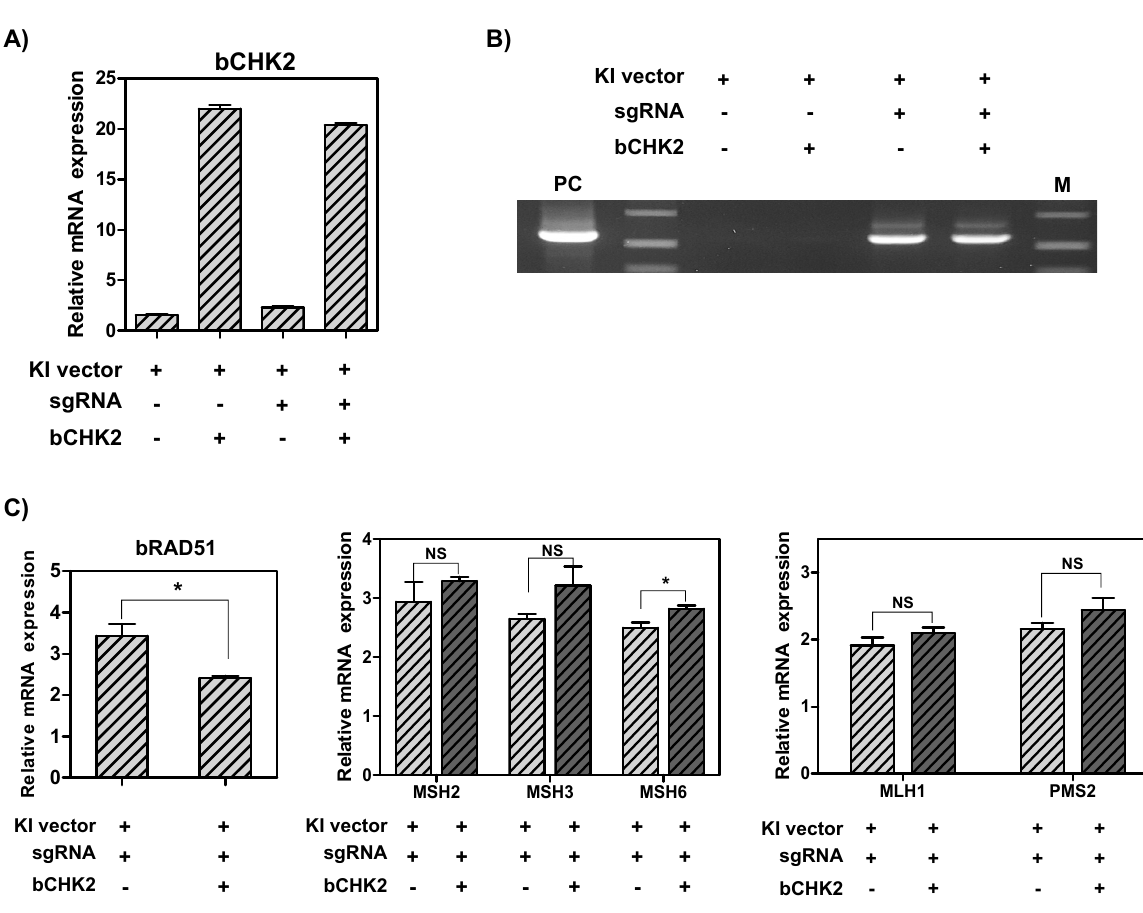
Figure 6. The mRNA levels of CHK2 and DNA MMR-related genes, and CRISPR/Cas9-mediated knock-in efficiency in MAC-T cells induced overex - pression of CHK2 gene. (A) The mRNA levels of CHK2 gene. (B) Polymerase chain reaction analysis of knock-in efficiency. M, DNA size marker (1 kb ladder). (C) The mRNA levels of RAD51 and DNA MMR-related genes. CHK2, Checkpoint kinase 2; MMR, mismatch repair; MAC-T, bovine mam - mary epithelial cells; RAD51, RAD51 recombinase. Error bars show the standard deviation from each sample. NS, no statistical difference; *